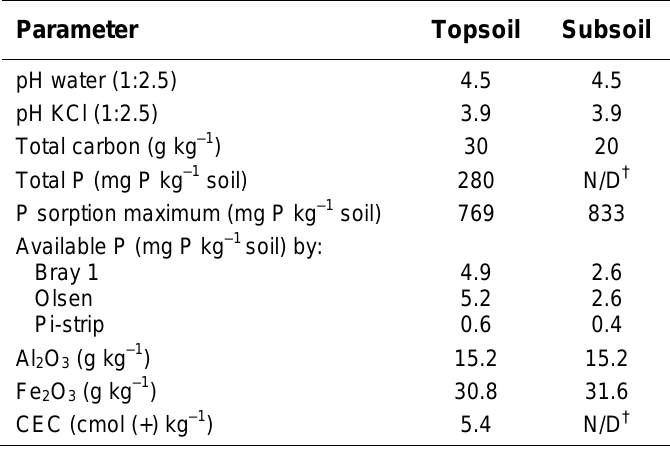
Characteristics of the Top- and Subsoil Parameter Parameter